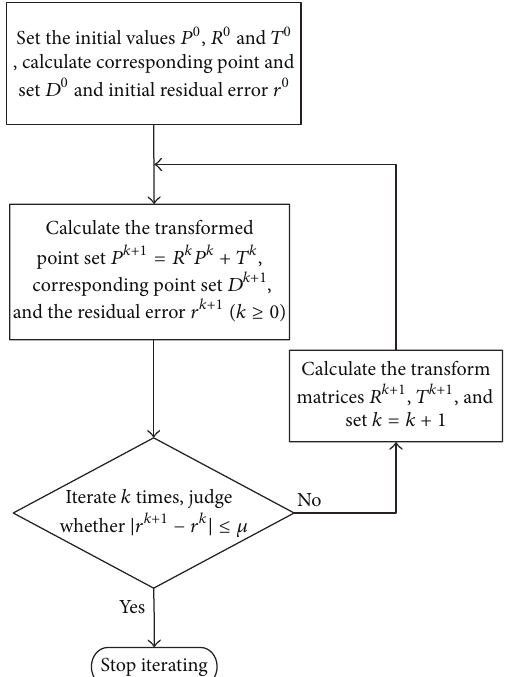
Figure 2: The flow chart of precise registration.